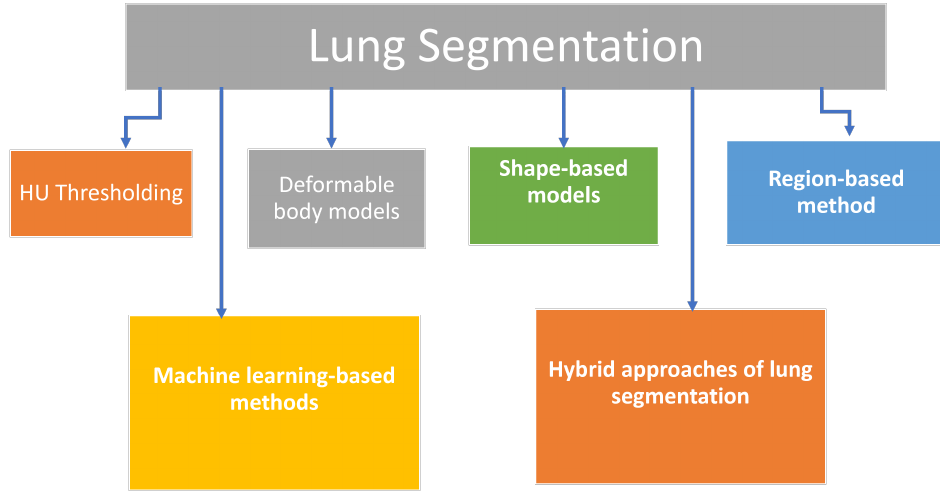
Figure 2. Main Categories of Lung